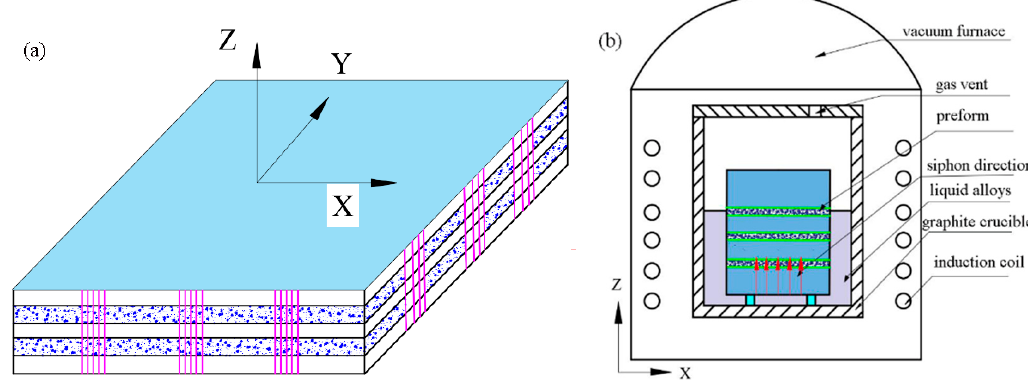
Figure 1. A diagram of a carbon felt infiltration model and the siphon tooling mold. ( a ) Schematic of 2D needle-punched carbon felts; ( b ) A schematic view of the siphon tooling mold.